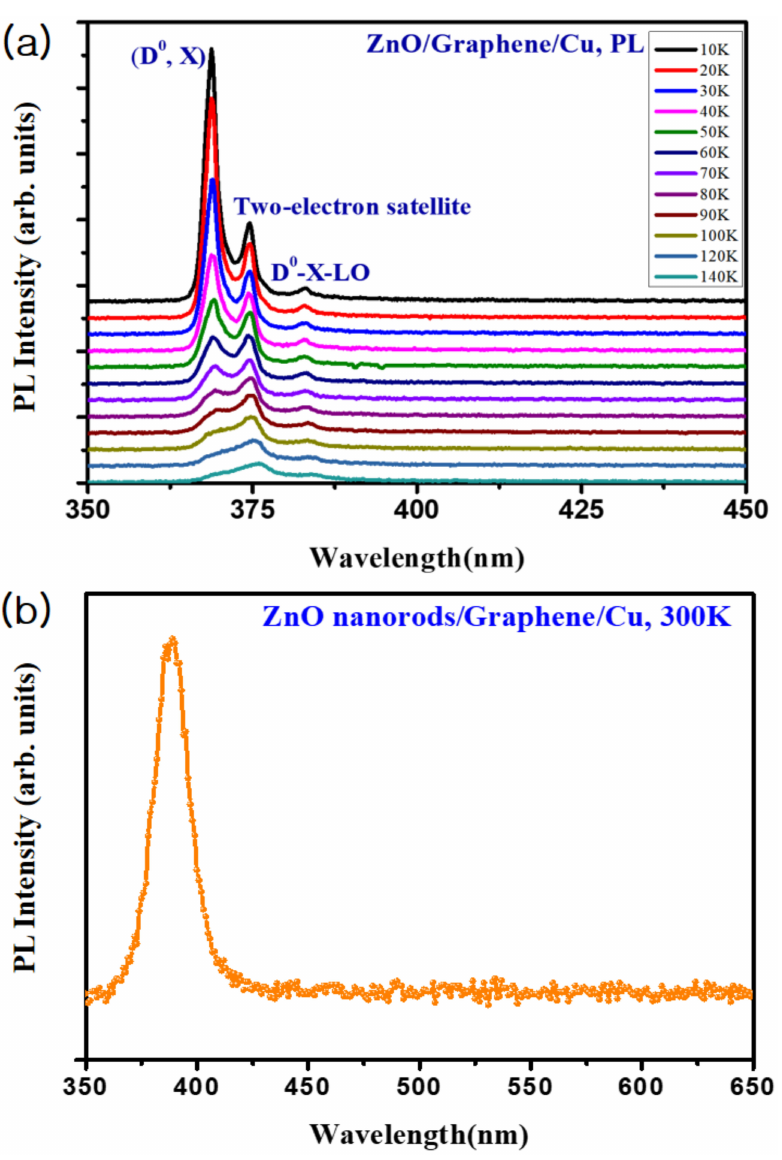
Figure 5. ( a ) Low temperature-dependent PL (photoluminescence) spectra in a temperature range of 10–140 K and ( b ) room-temperature PL spectrum for the ZnO NRs/graphene hybrid-nanostructure. Generally, optical absorption in ZnO occurs only in the UV region. Since the morphol- ogy of ZnO NRs has a high surface-to-volume ratio, there can be defects on the surface of the ZnO NRs [21,22]. Then, the surface states induced by these defects lead to an absorption in a visible region [13,23]. The previous study revealed that the configuration and size of the ZnO NR play an important role in light scattering and trapping [42,43], so that the surface area related to the visible PL is ascribed from the surface states. Meanwhile, in our ZnO NRs fabricated on the graphene/Cu structure, there are no PL peaks observed in the visible wavelength except the UV region, indicating a highly crystalline ZnO NR structure. This result coincides well with the data obtained by the XRD result in Figure